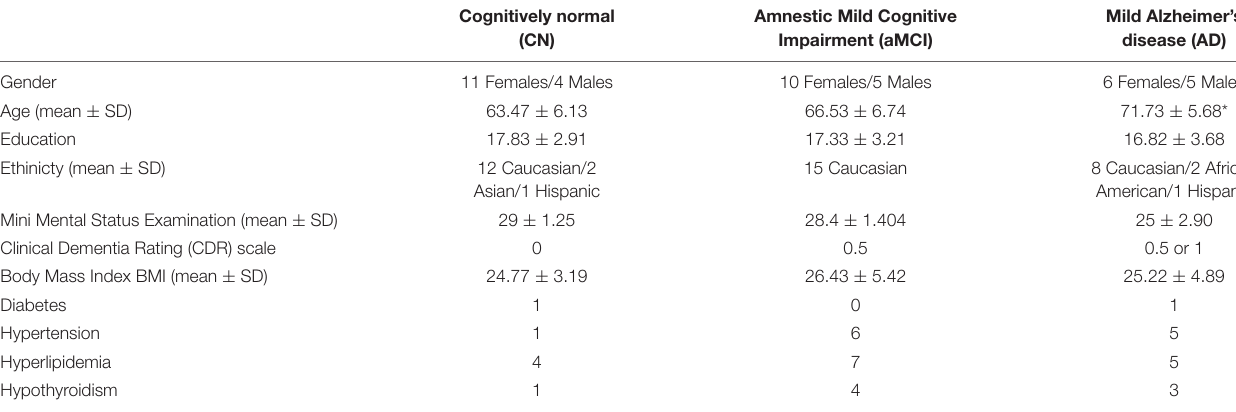
TABLE 2 | Demographics of the participant enrolled in the study.